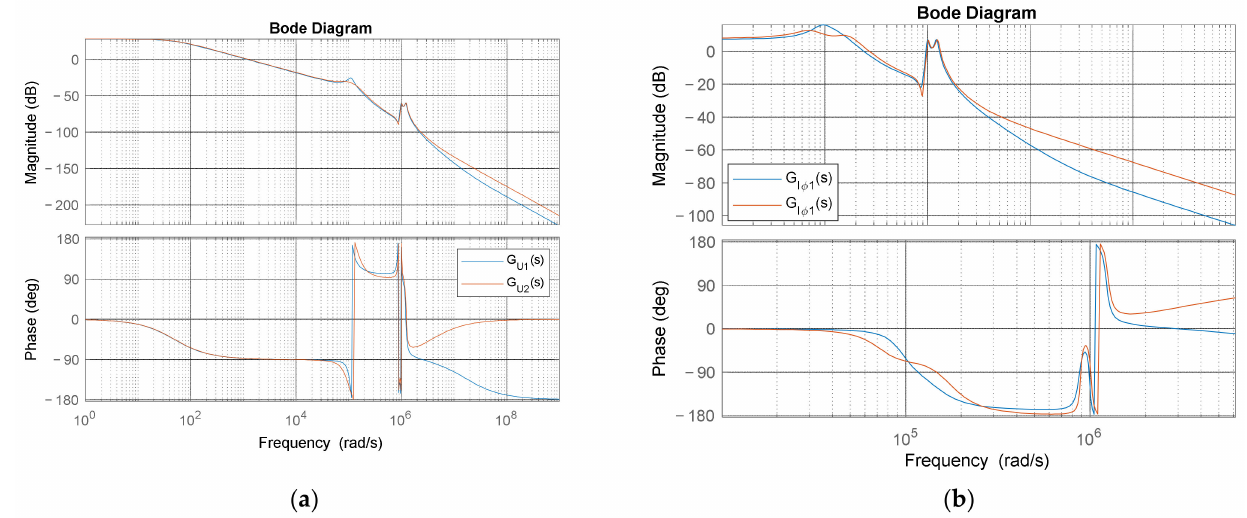
Figure 8. Open loop bode plot of the IPT system using double DD coils. ( a ) voltage transfer function, ( b ) current transfer